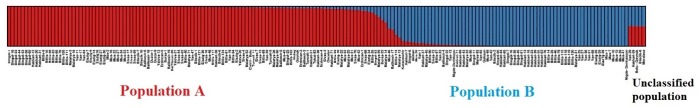
Population structure analysis of Turkish common bean landraces using silicoDArT markers.